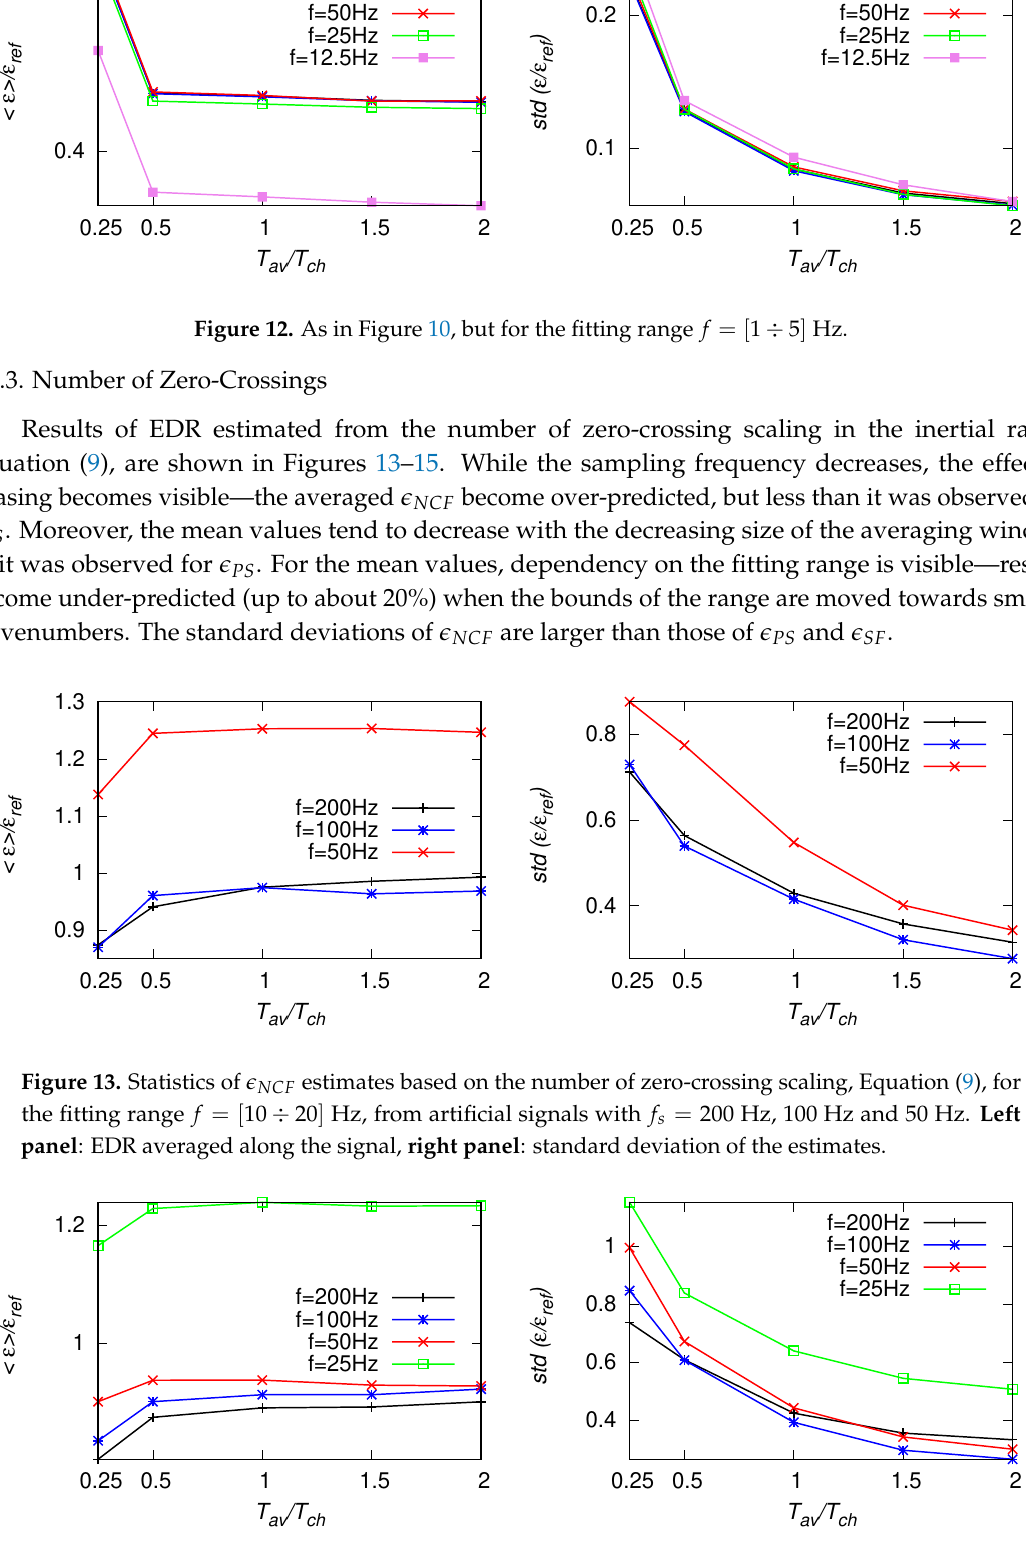
Figure 14. As in Figure 13, but for the fitting range f = [ 5 ÷ 10 ]